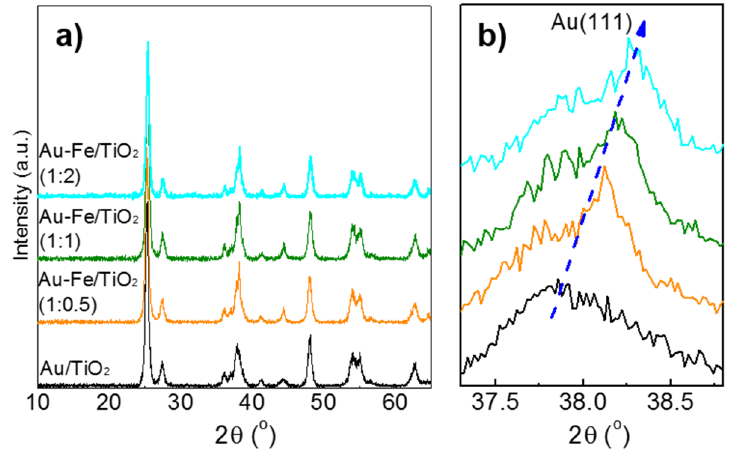
Figure 1. ( a ) XRD patterns, and ( b ) enlarged section of XRD patterns of Au / TiO 2 and Au-FeO x / TiO 2 catalysts with different molar ratios of Au:Fe. Table 1. Textural properties and bandgap of Au / TiO 2 and Au-FeO x / TiO 2 catalysts.